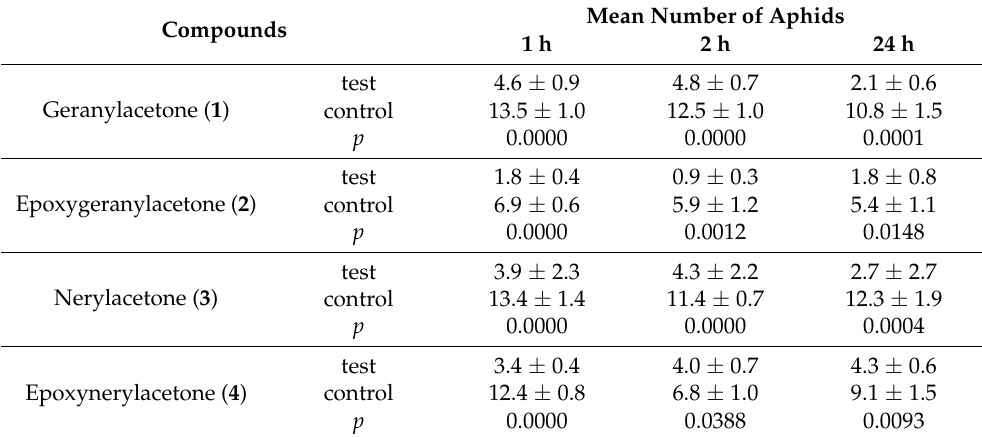
Figure 2. Settling success of Myzus persicae on Brassica rapa subsp. pekinensis exposed to geranylacetone ( 1 ), epoxygeranylacetone ( 2 ), nerylacetone ( 3 ), and epoxynerylacetone ( 4 ). The same plant species was used to maintain the aphid stock culture. The relative index of deterrence (DI) after 1, 2, and 24 h. Asterisks indicate statistically significant differences between the numbers of aphids on control and treated leaves according to the Student t -test: * p < 0.05, ** p < 0.01, *** p < 0.001. Table 1. Effect of geranylacetone ( 1 ), epoxygeranylacetone ( 2 ), nerylacetone ( 3 ), epoxynerolacetone ( 4 ) on settling of Myzus persicae on Brassica rapa subsp. pekinensis .